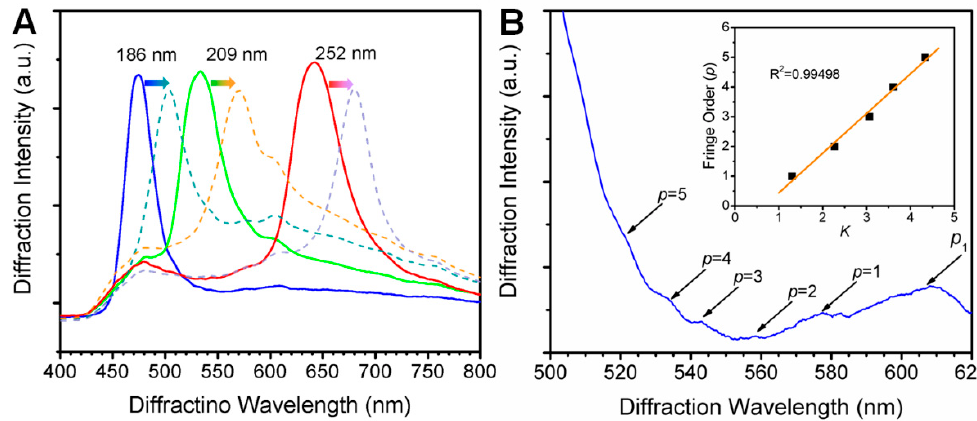
Figure 4. ( A ) Comparison of diffraction spectra of PS CPCs before and after PVA infiltration; ( B ) an example of the enlarged view of the FPF evident in 186 nm PS assembled CPC. The insert plots the relationship between the interference order and the correlation coefficient K .